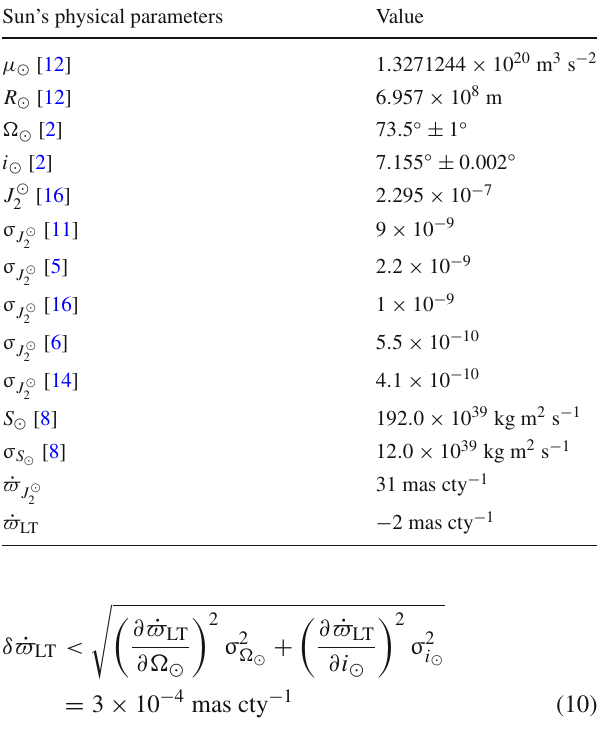
Table1 Relevant Sun’s physical parametersalong withthemost recent uncertainties for some of them appeared in the literature, and nominal quadrupolar and Lense–Thirring perihelion precessions for Mercury. As far as S (cid:3) is concerned, the values quoted for its size and uncertainty were obtained by calculating the mean and the standard deviation of the figures quoted in Table 1 of Iorio [8] Sun’s physical